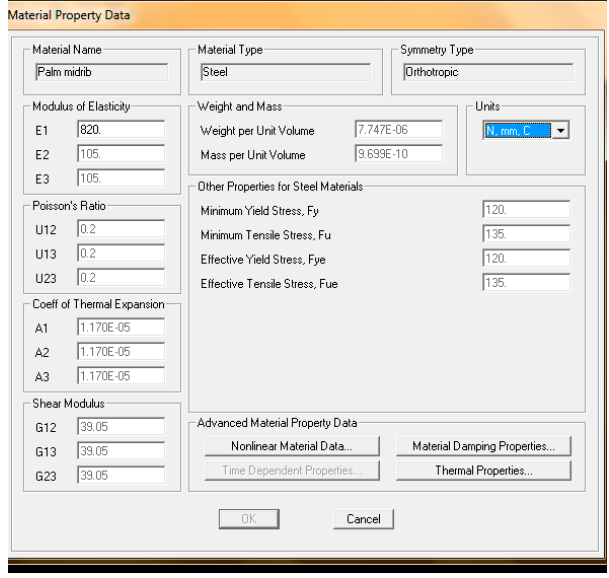
Figure 28. The defined mechanical properties of date palm midribs in SAP2000.